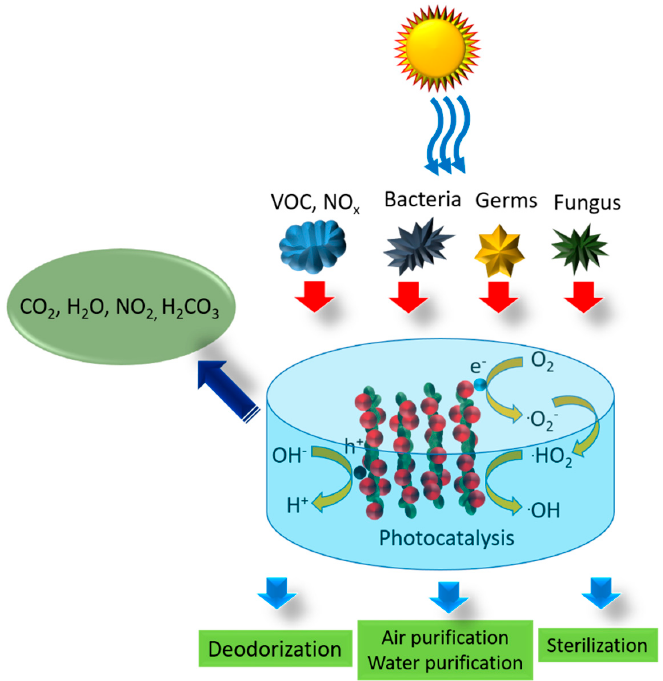
Figure 1. Schematic for the representation of environmental remediation by photocatalysis.